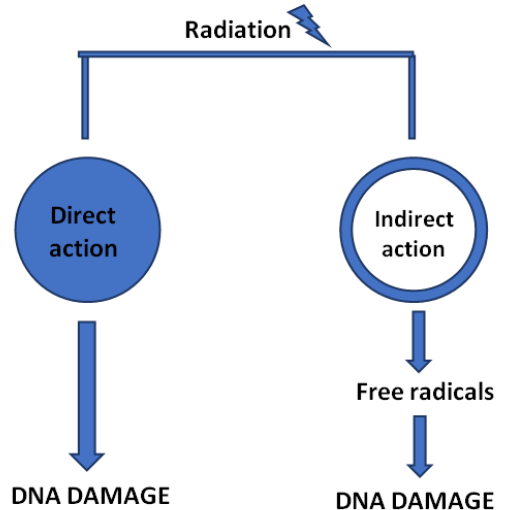
Figure 4. Direct and indirect influence of ionizing radiation leading to the damage of DNA